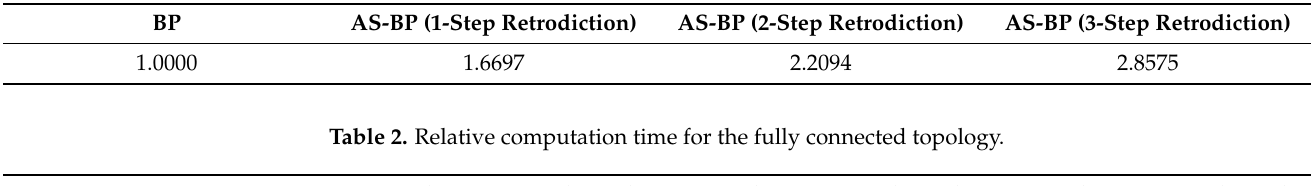
Table 1. Relative computation time for the chain topology.